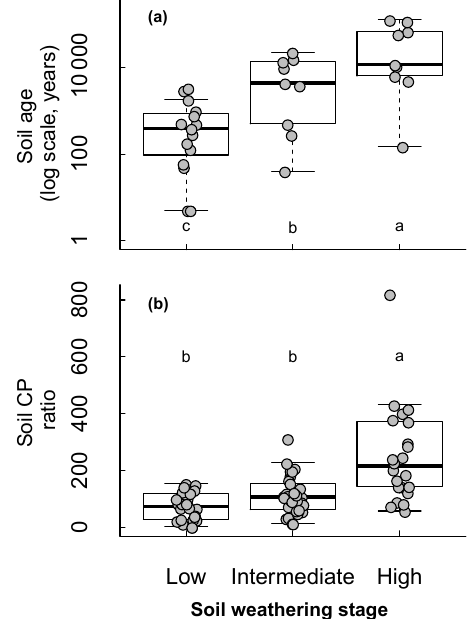
Figure 4. Soil weathering stage relationship with soil age ( n = 33) and C : P ratio ( n = 78) on natural ecosystems.